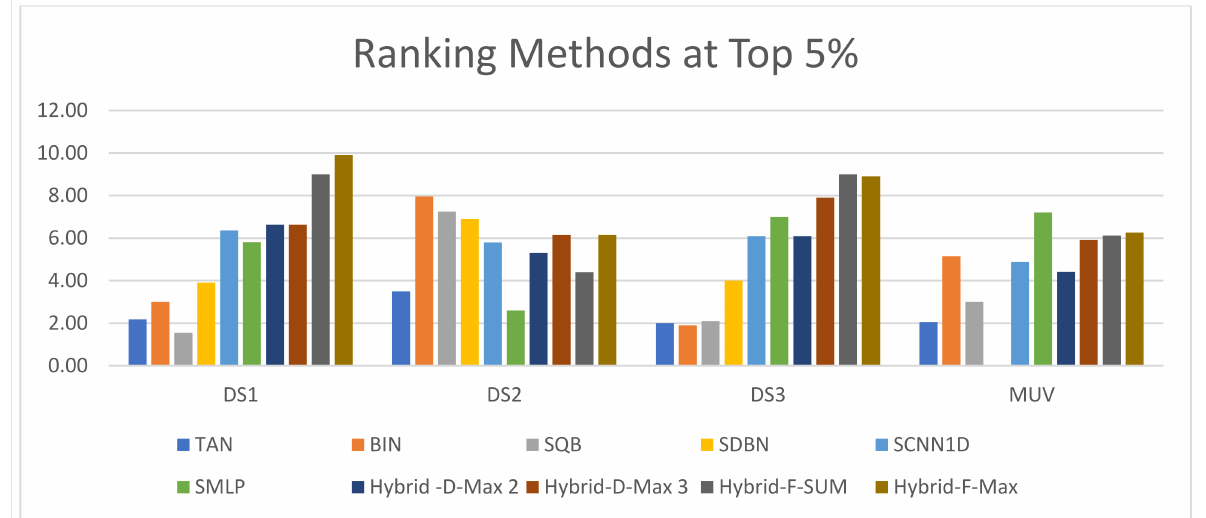
Figure 17. The ranking methods at the top